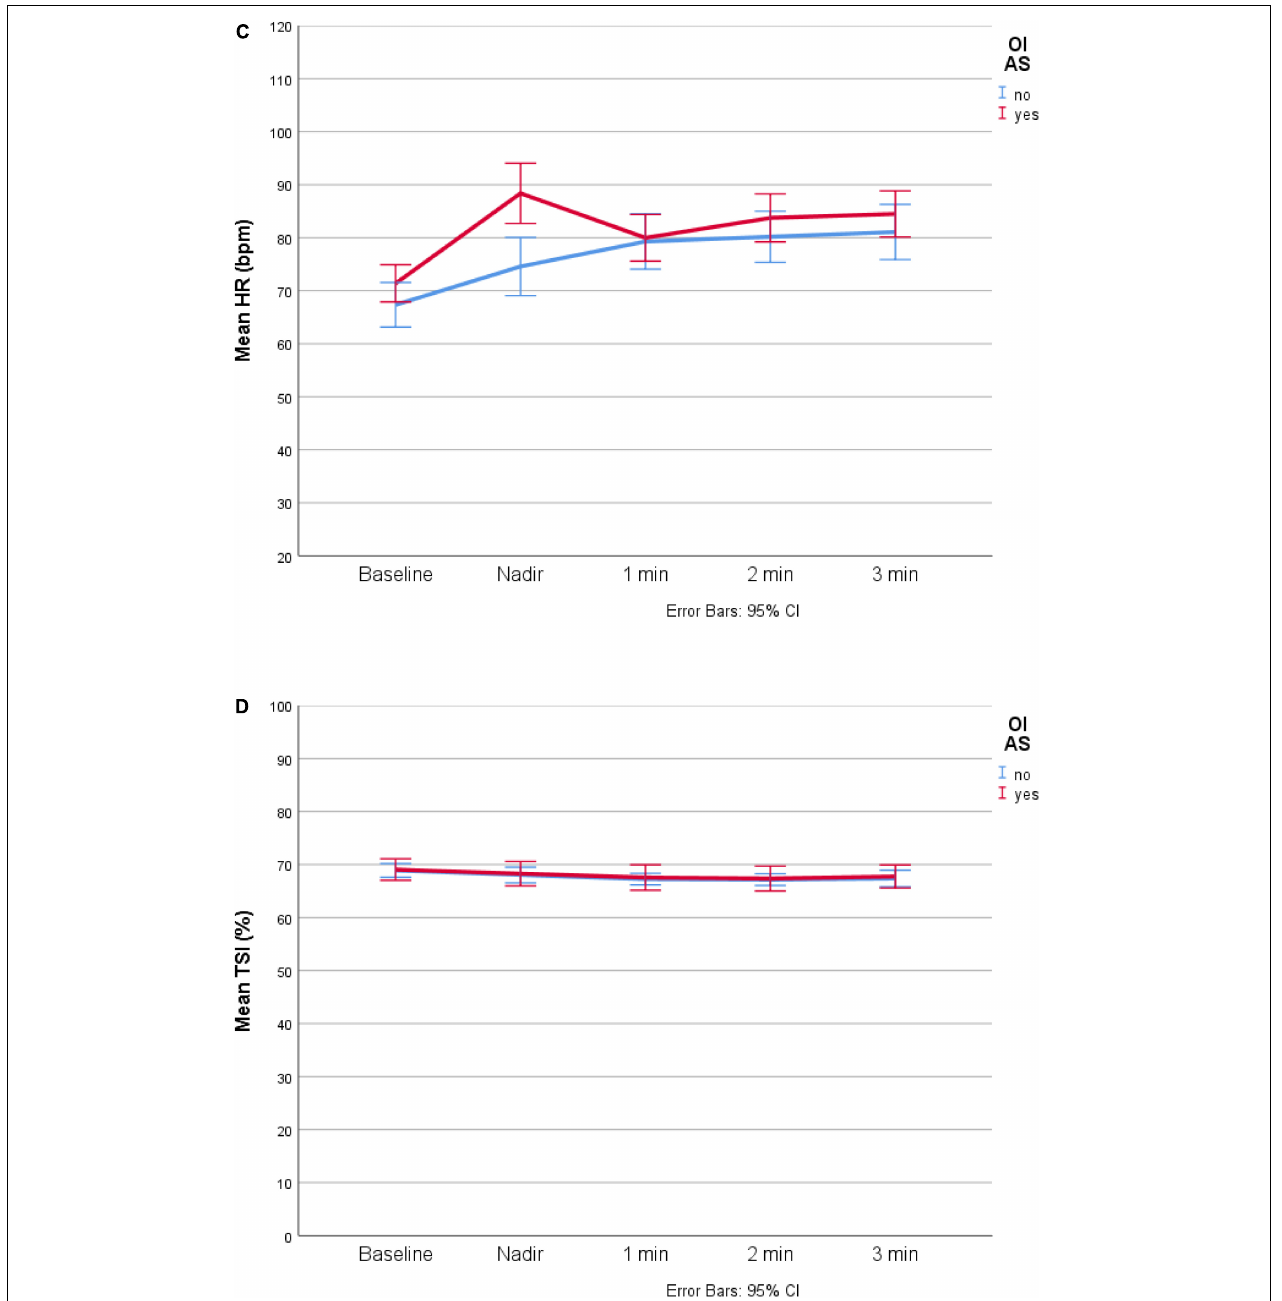
FIGURE 1 | | Haemodynamic visualisation of OI AS ( n = 56) and non-OI AS ( n = 29) groups. (A) Systolic blood pressure (SBP). (B) Diastolic blood pressure (DBP). (C) Heart rate (HR). (D) Tissue saturation index (TSI). bpm, beats per minute; CI, confidence